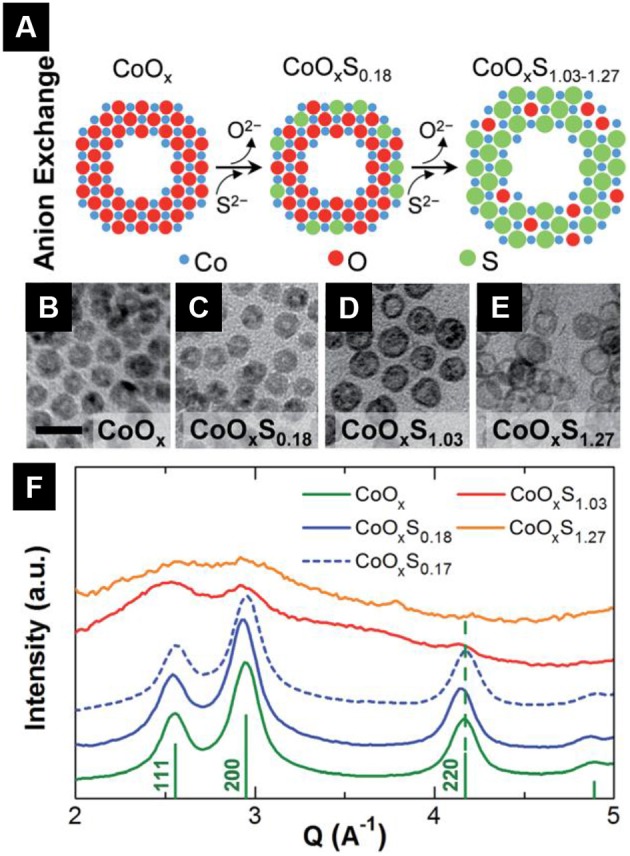
(A) Synthetic strategy of CoOxSy hollow nanoparticles. TEM micrographs of CoOxSy nanoparticles with y = 0 (B); 0.18 (C); 1.03 (D); 1.27 (E). (F) Rotationally averaged SAED patterns of the various CoOxSy nanoparticles. Reference lines in green indicate CoO Bragg peaks (JCPDS 00-048-1719). Adapted from Nelson et al. (2016) with permission of the Royal Chemical Society.